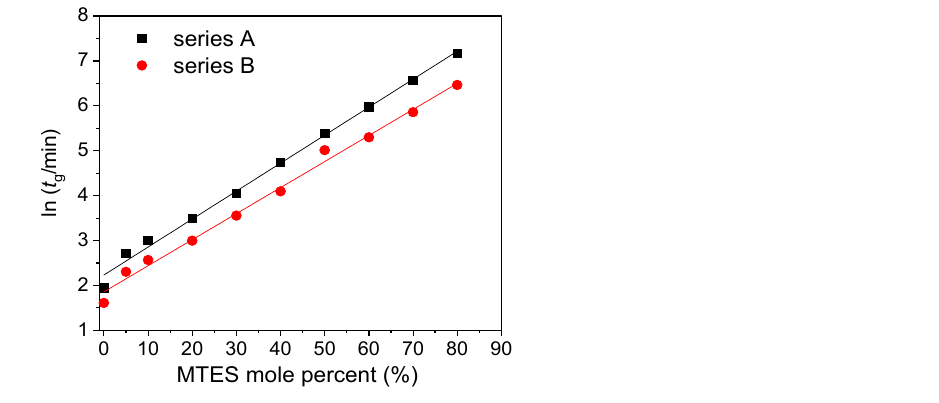
Figure 2. ( a ) Evolution of low-temperature nitrogen adsorption/desorption isotherms with MTES content. ( b ) Comparison between the apparent surface area evolution with the MTES mole percent and the acid catalysts content (series A and series B labels represent the pH = 2.0 and pH = 4.5).